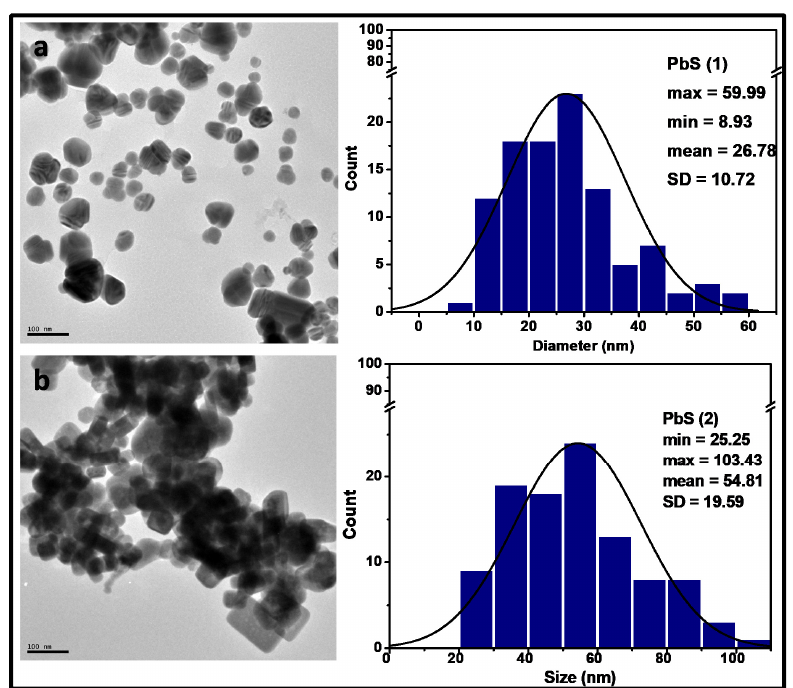
Figure 2. Transmission electron microscopy (TEM) micrographs showing the morphology of synthesized ( a ) PbS(1) and ( b ) PbS(2) nanoparticles with their respective particle size distribution histogram. SD stands for standard deviation.